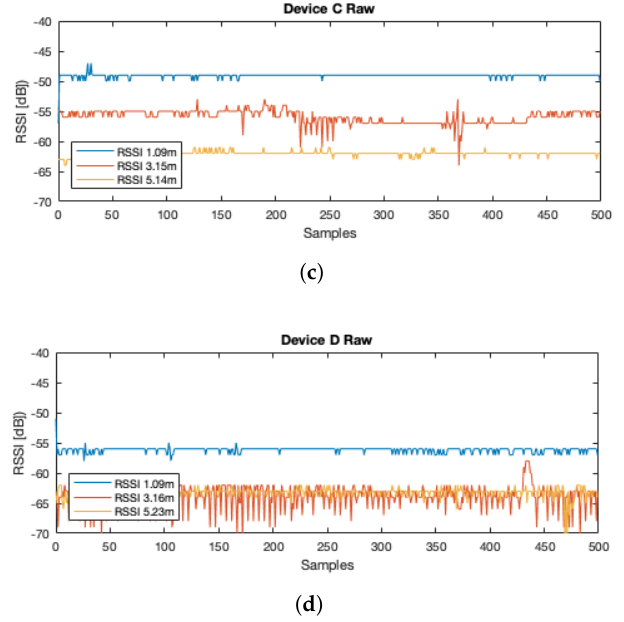
Figure 9. RSSI measurements of three UAV positions for each sensing module: ( a ) Raw data device A, ( b ) Raw data device B, ( c ) Raw data device C, and ( d ) Raw data device D.